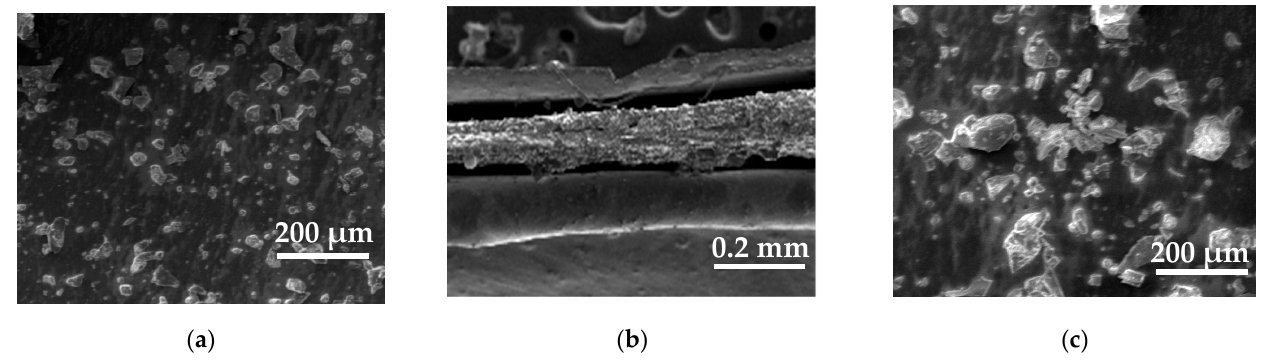
Figure 2. SEM images of ( a ) AC/Lig-MnO 2 , ( b ) the supercapacitor interface, and ( c ) Lig-MnO 2 .